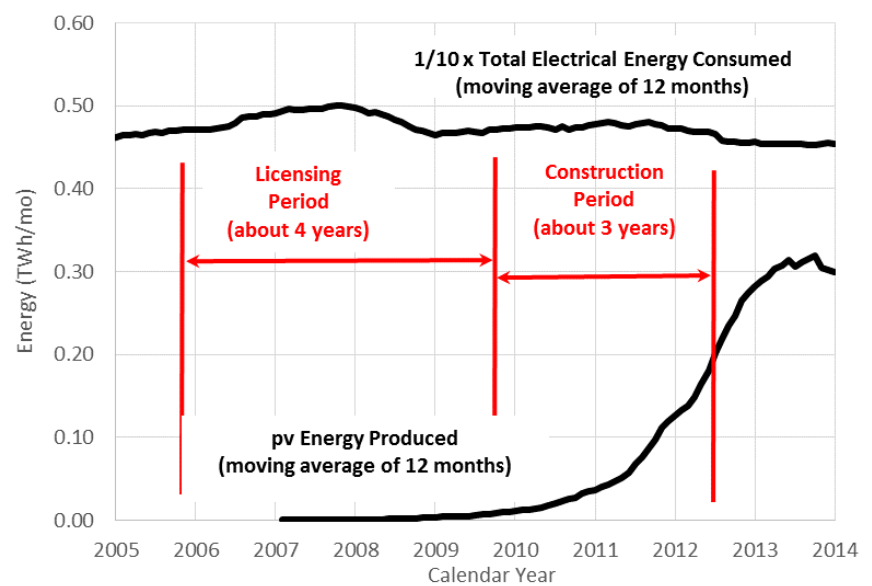
Figure 5. Electricity produced by photovoltaics. Data from Hellenic Electricity Market Operator